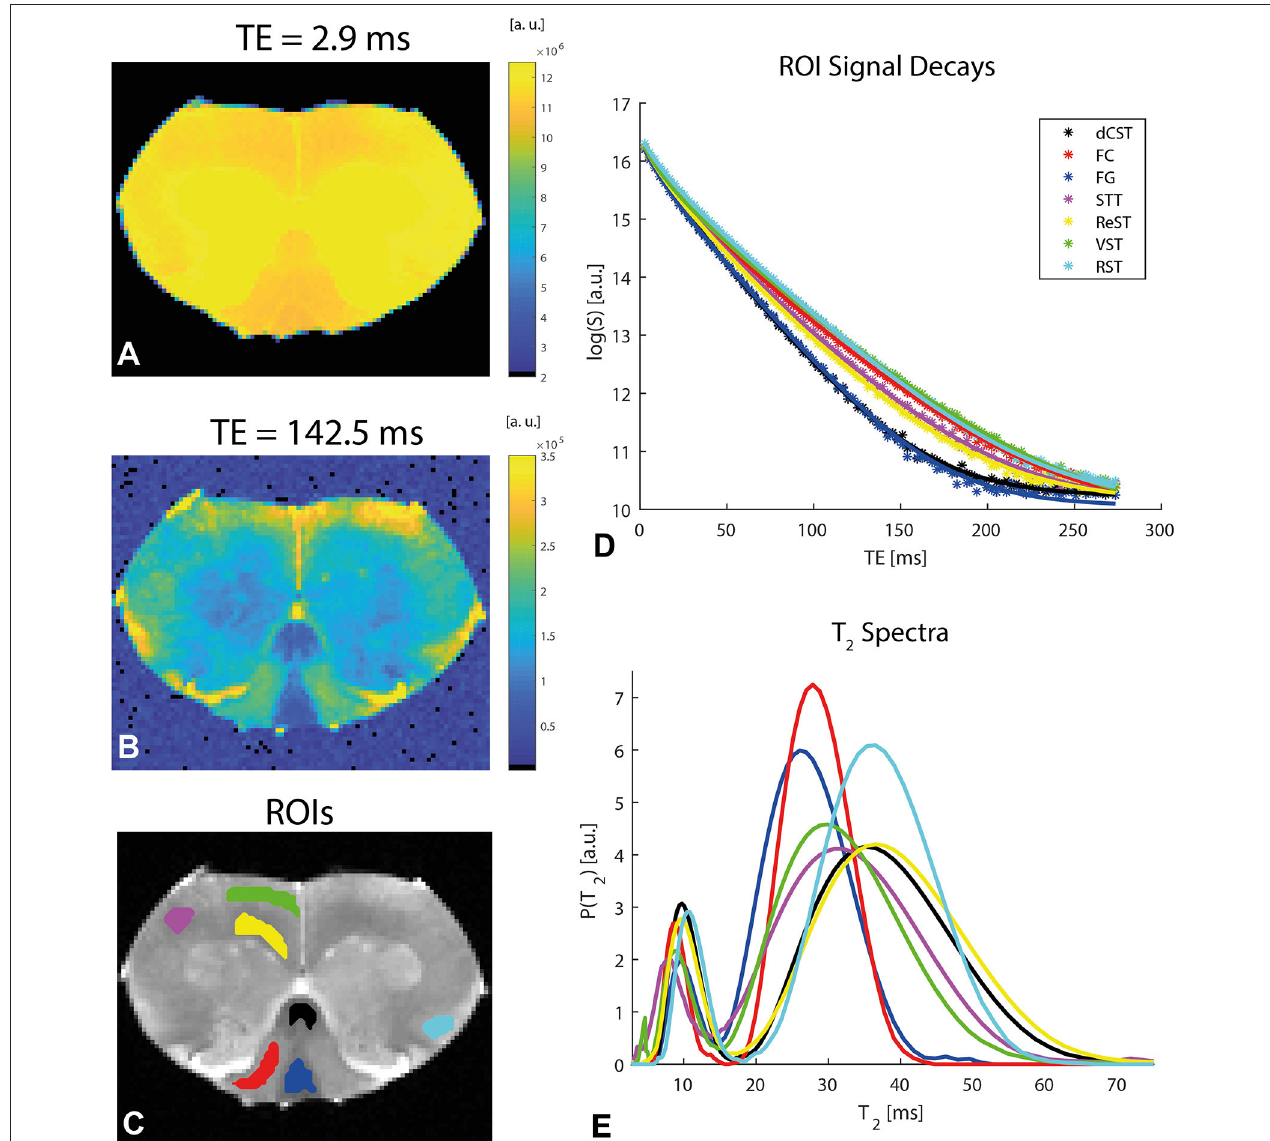
FIGURE 6 | Relaxation data and analysis in a representative spinal cord. (A,B) Preprocessed data at short and long TEs, respectively, reveal excellent SNR. (C) ROI definitions. (D) Mean ROI signal decays with TE (symbols) along with their respective fits (solid lines). N.b. the log scale in the ordinate. (E) T 2 spectra (plotted in log scale in the abscissa) extracted from an iLT fit to the ROI data. The myelin water is associated with the peak corresponding to shorter T 2 values. The ROI colors in (C) correspond to the color of the plots in (D,E)